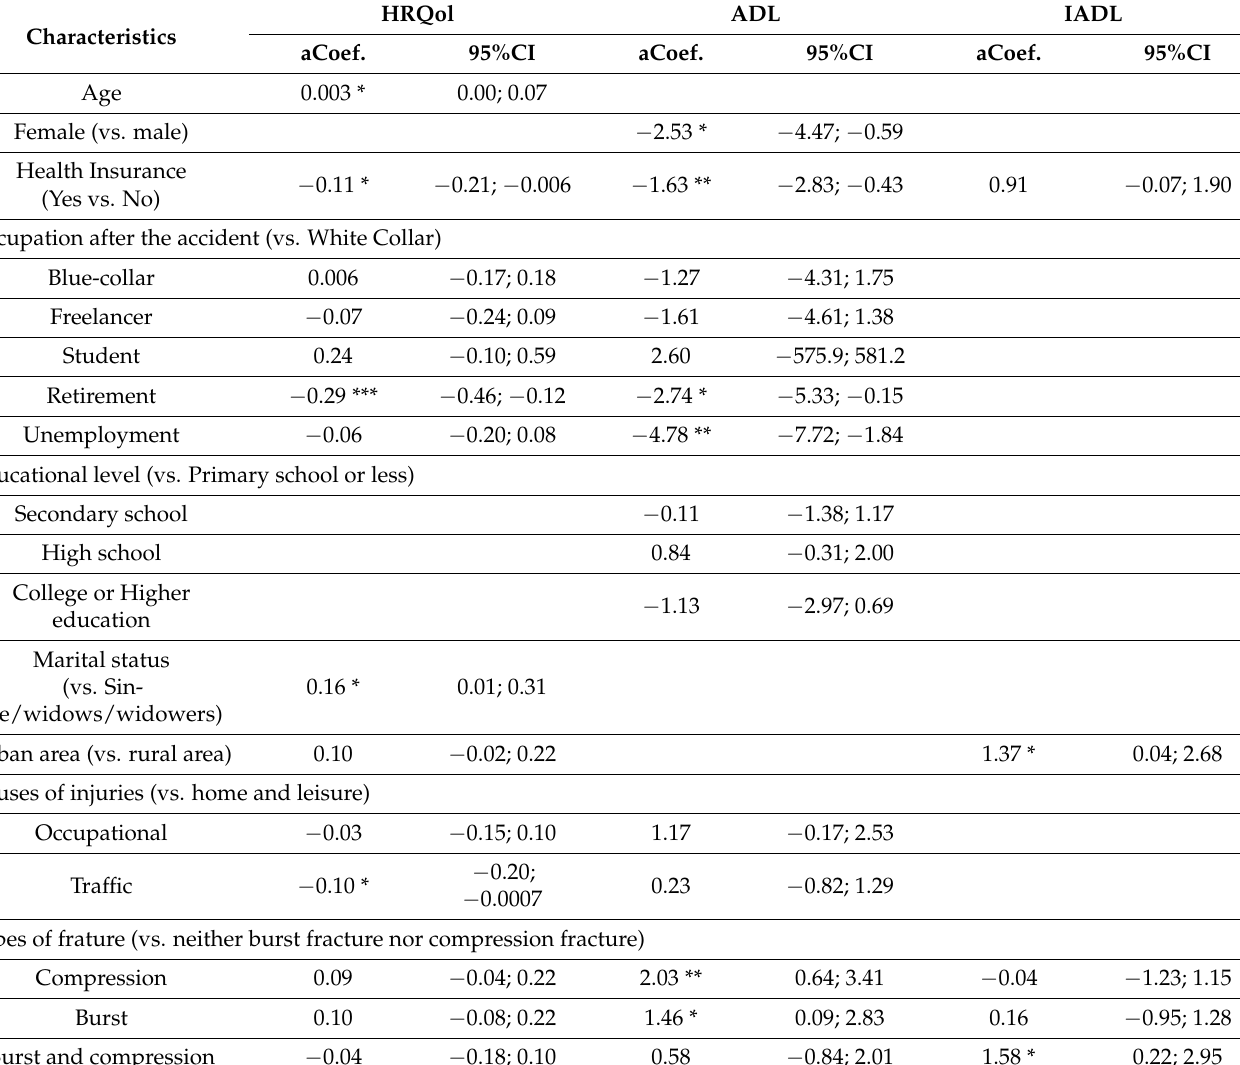
Table 3. Multivariate Tobit regression analysis for HRQOL, ADL, IADL index